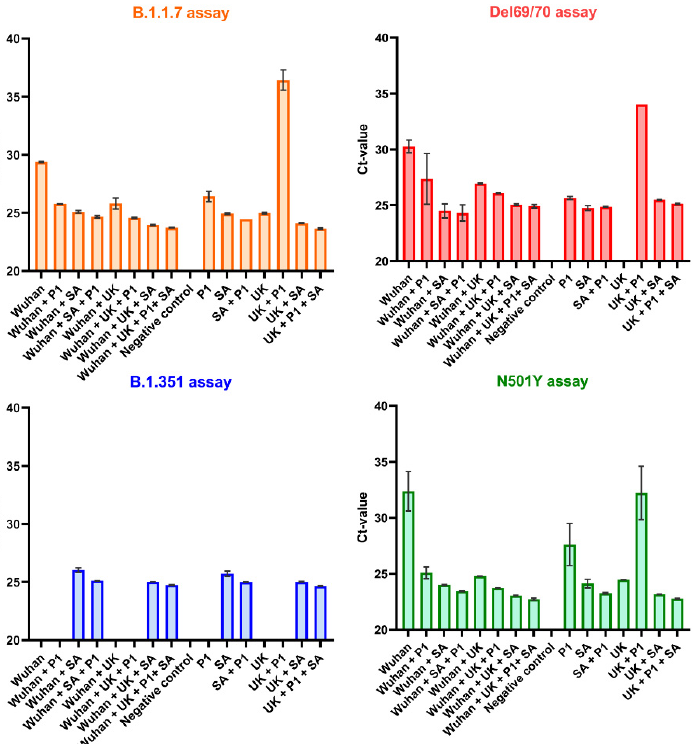
Figure 2. Specificity of the different primer sets (B.1.1.7 = orange; S ∆ 69/70 = red; B.1.351 = blue; and N501Y assay = green) to reaction mixtures ( x -axis) containing different combinations of variants of concern RNA with real-time quantitative PCR. The experiment was performed in duplicate and the mean Ct-value was plotted for each reaction mixture. (Wuhan = wild type; UK = B.1.1.7; SA =